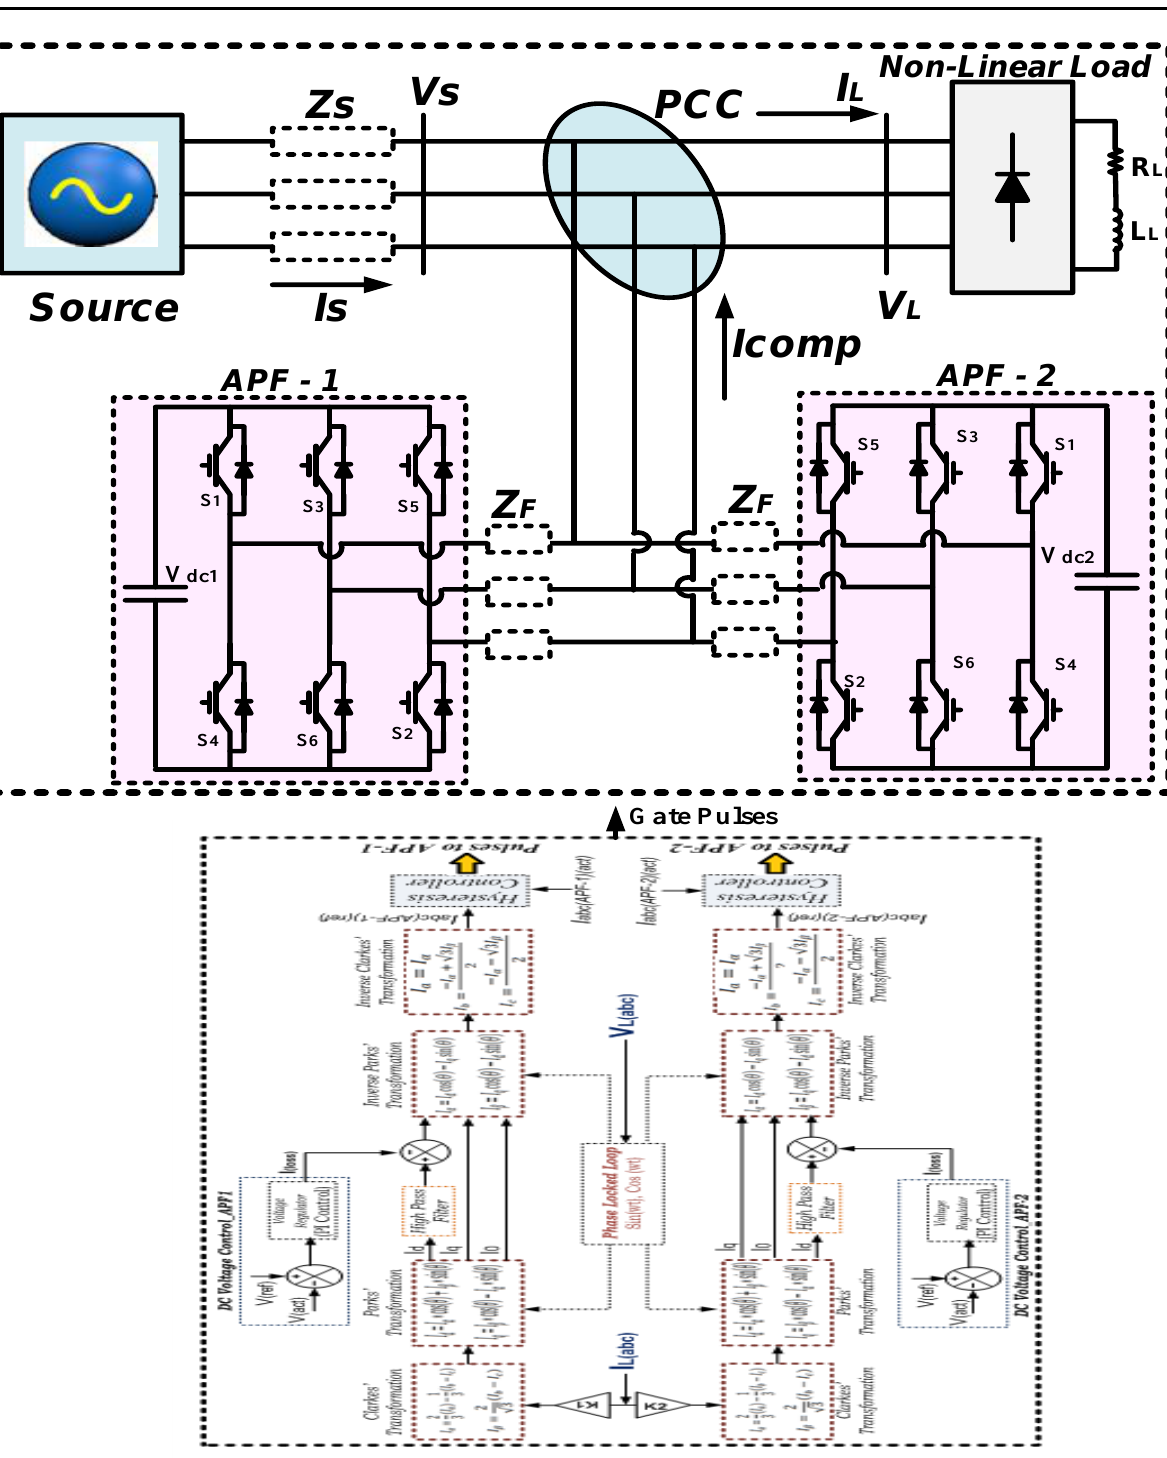
Figure 7. Complete arrangement of parallel APF with modified d-q reference